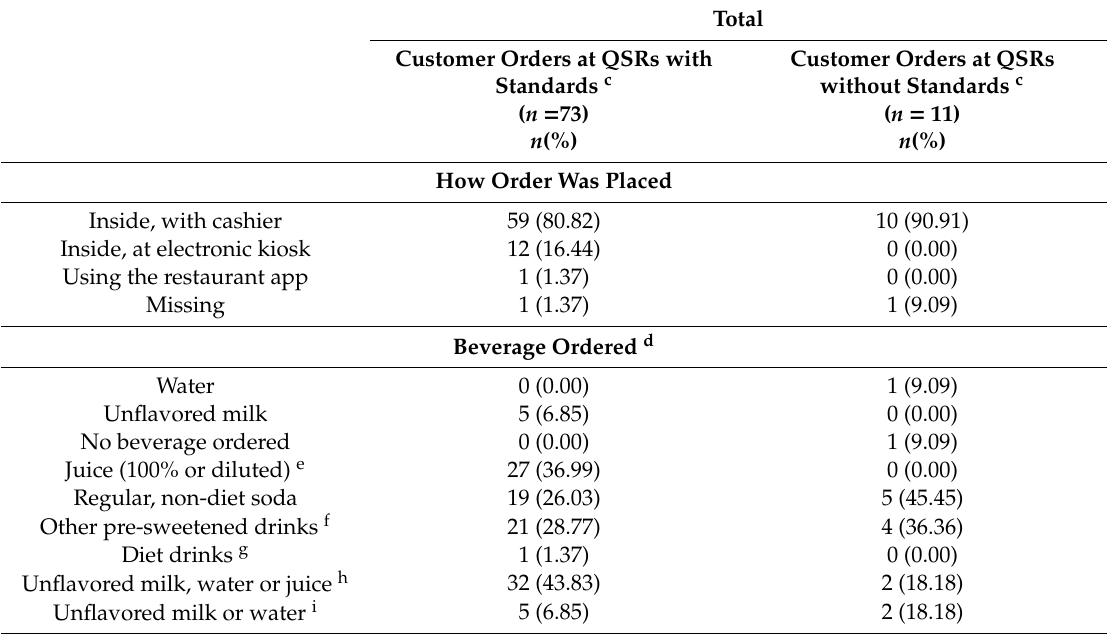
Table 4. Characteristics of customer orders placed at quick-service restaurants (QSRs; N = 84 customer orders) a,b